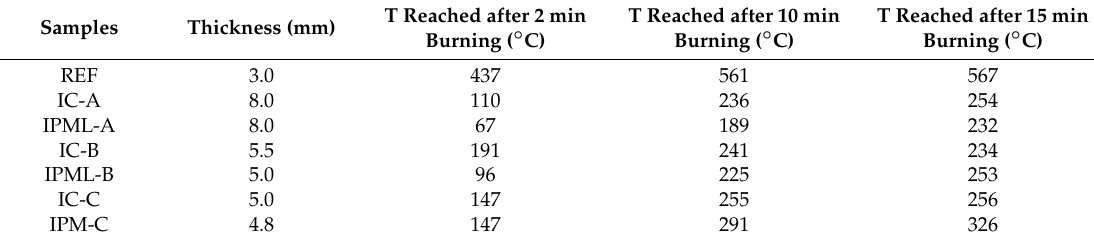
Table 3. Temperature reached after 2, 10, and 15 min burning, for each sample